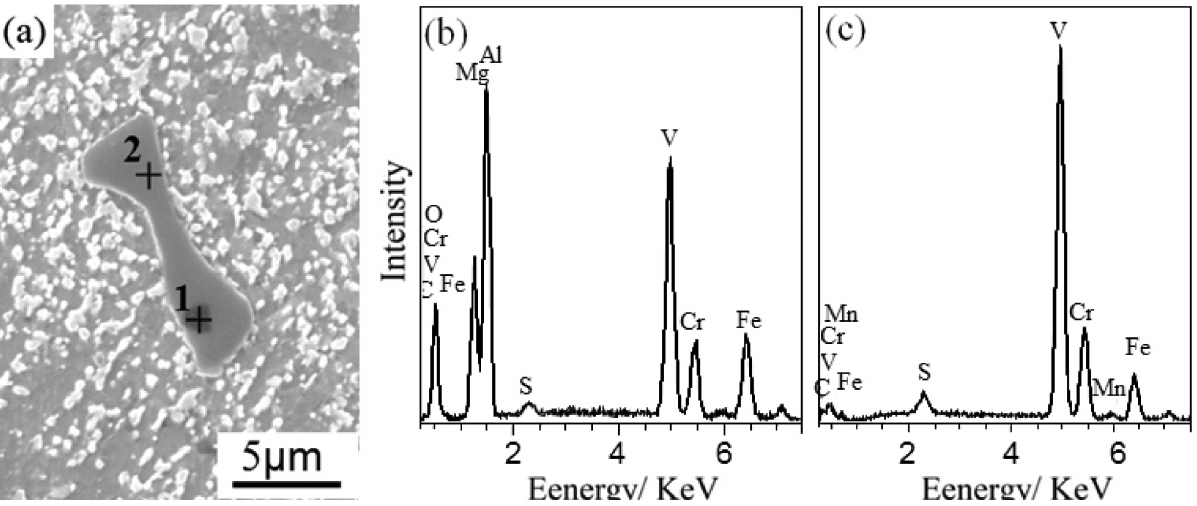
Fig. 5: Al 2 O 3 ·MgO spinel surrounded by a V-rich primary carbide. (a) SEM image; (b) EDS spectrum corresponding to point 1; (c) EDS spectrum corresponding to point